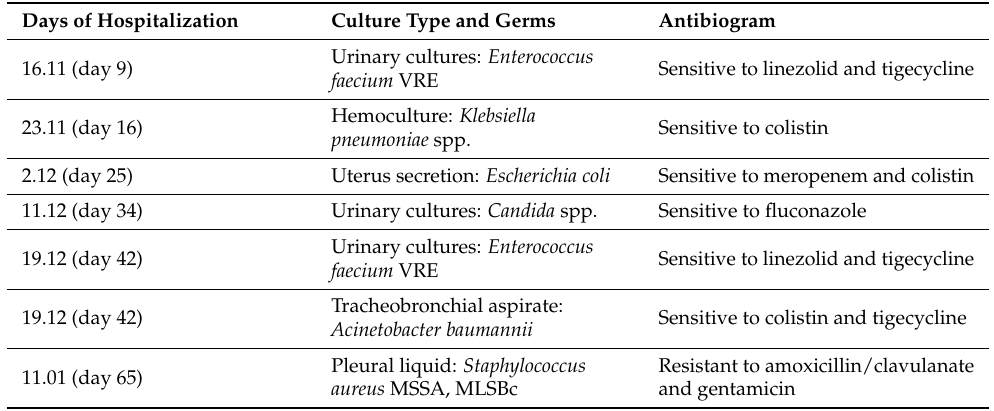
Table 2. Bacteria and fungus growth from cultures, including